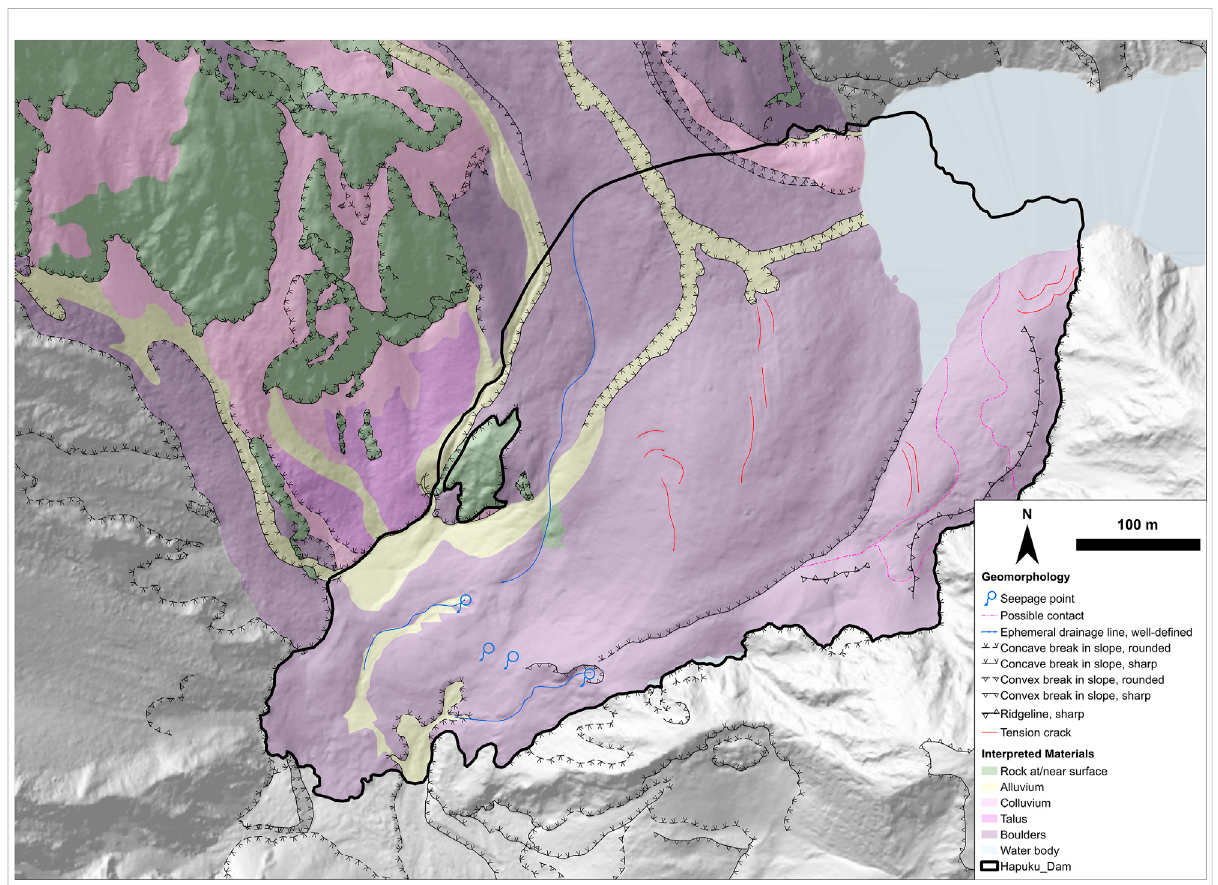
FIGURE 3 MorphologicalmapoftheHRAdamdeposit,showingmaterials,lineations,andseepagepointswithinthedamthatweremappedshortlyafterit formed. (Epoch 2 LiDAR DEM as base